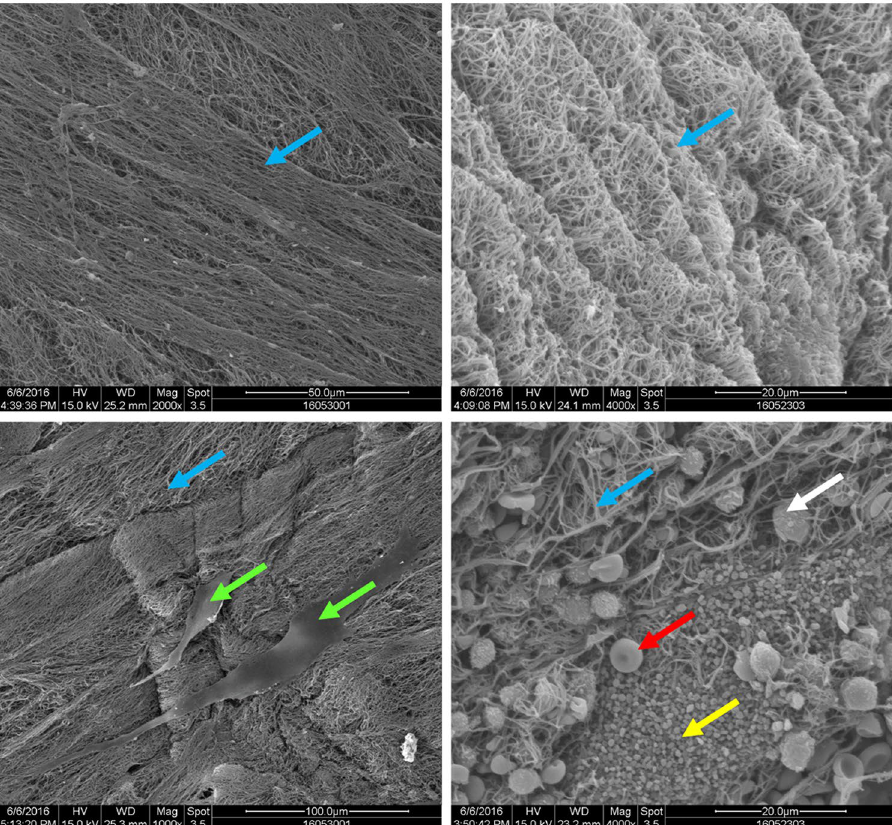
Figure 4. The ultrastructure of the CGF (scanning electron microscopy observation). The 3-dimensional network consisted predominantly of fibrin fibers (blue arrow). BMSCs can be observed growing well on the biomaterial surface (green arrow). Numerous platelets (yellow arrow), leukocytes (white arrow) and red blood cells (red arrow) are embedded in the